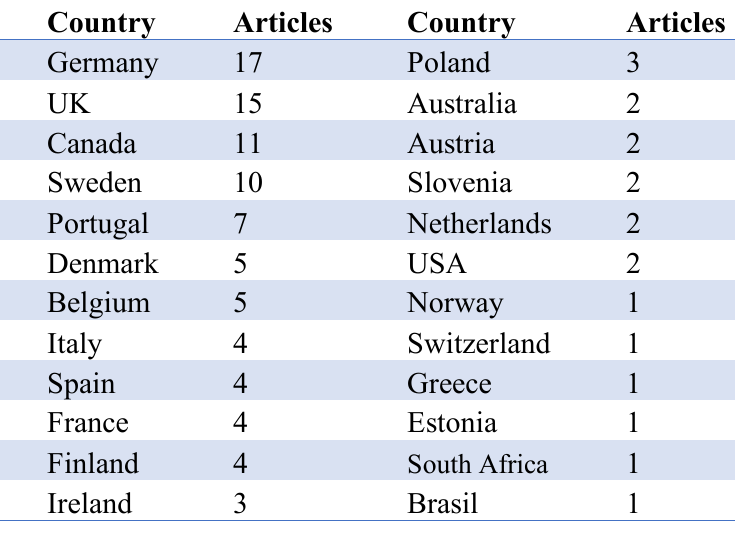
Table 1: Number of articles published in RELA 2009-2019 (issue 1) with first author located in a specific